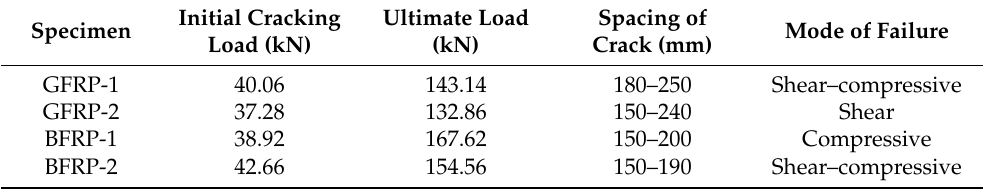
Table 5. Result of experimental GFRP and BFRP rebar-reinforced concrete specimens.